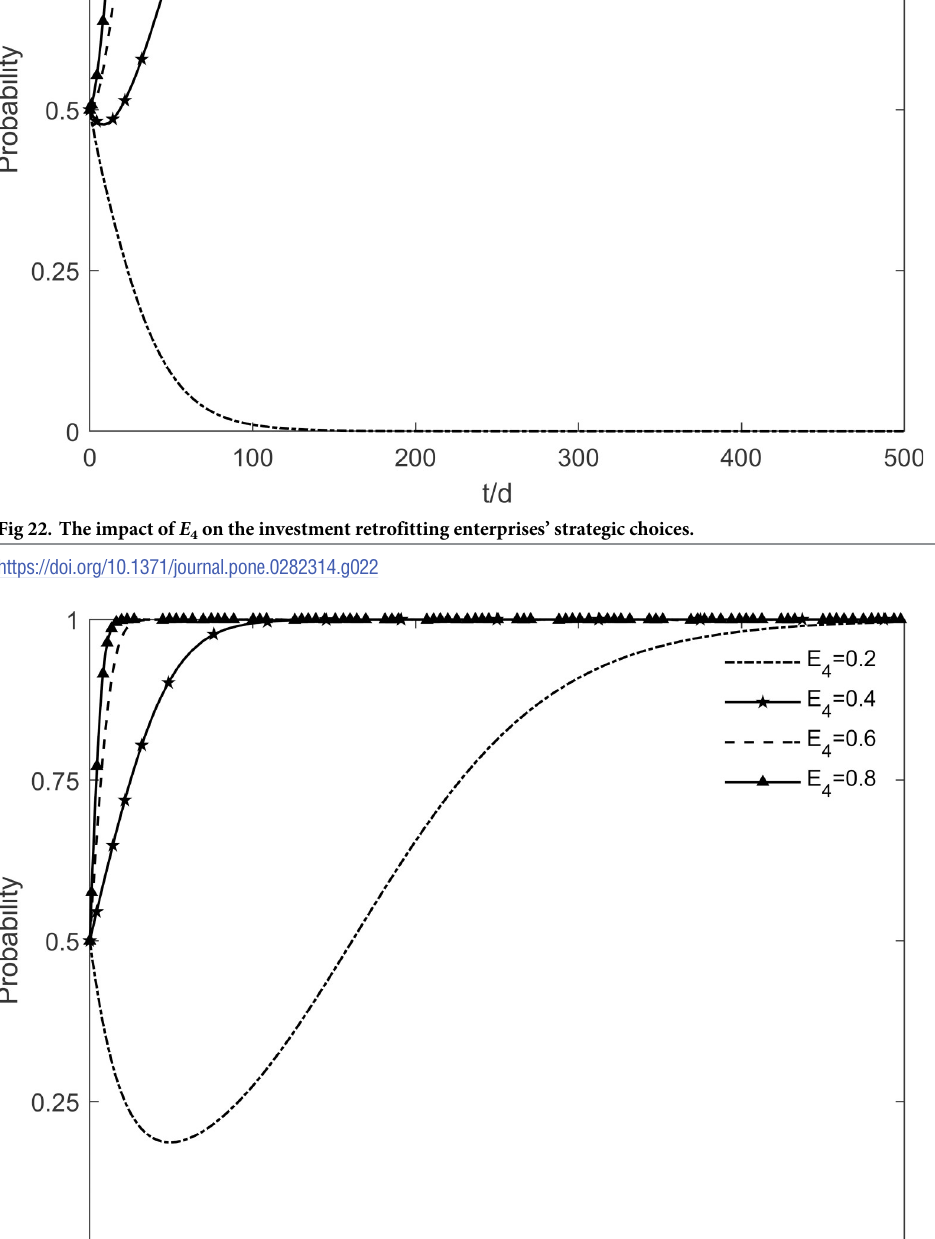
PLOS ONE | https://doi.org/10.1371/journal.pone.0282314 March 16,